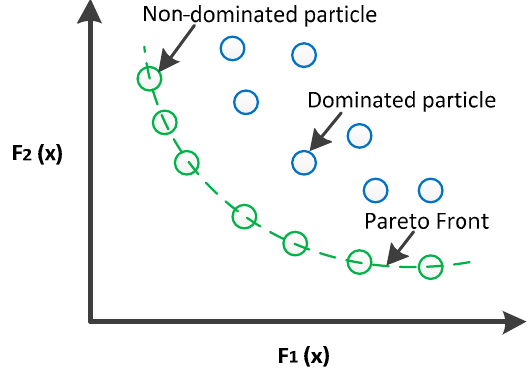
Figure 2. Dominated, non-dominated and Pareto-front solution set.